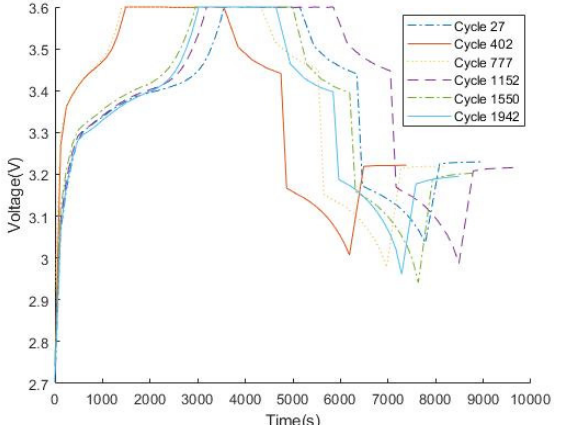
Figure 3 . Voltage variation during different capacity test cycles. Figure 3. Voltage variation during different capacity test